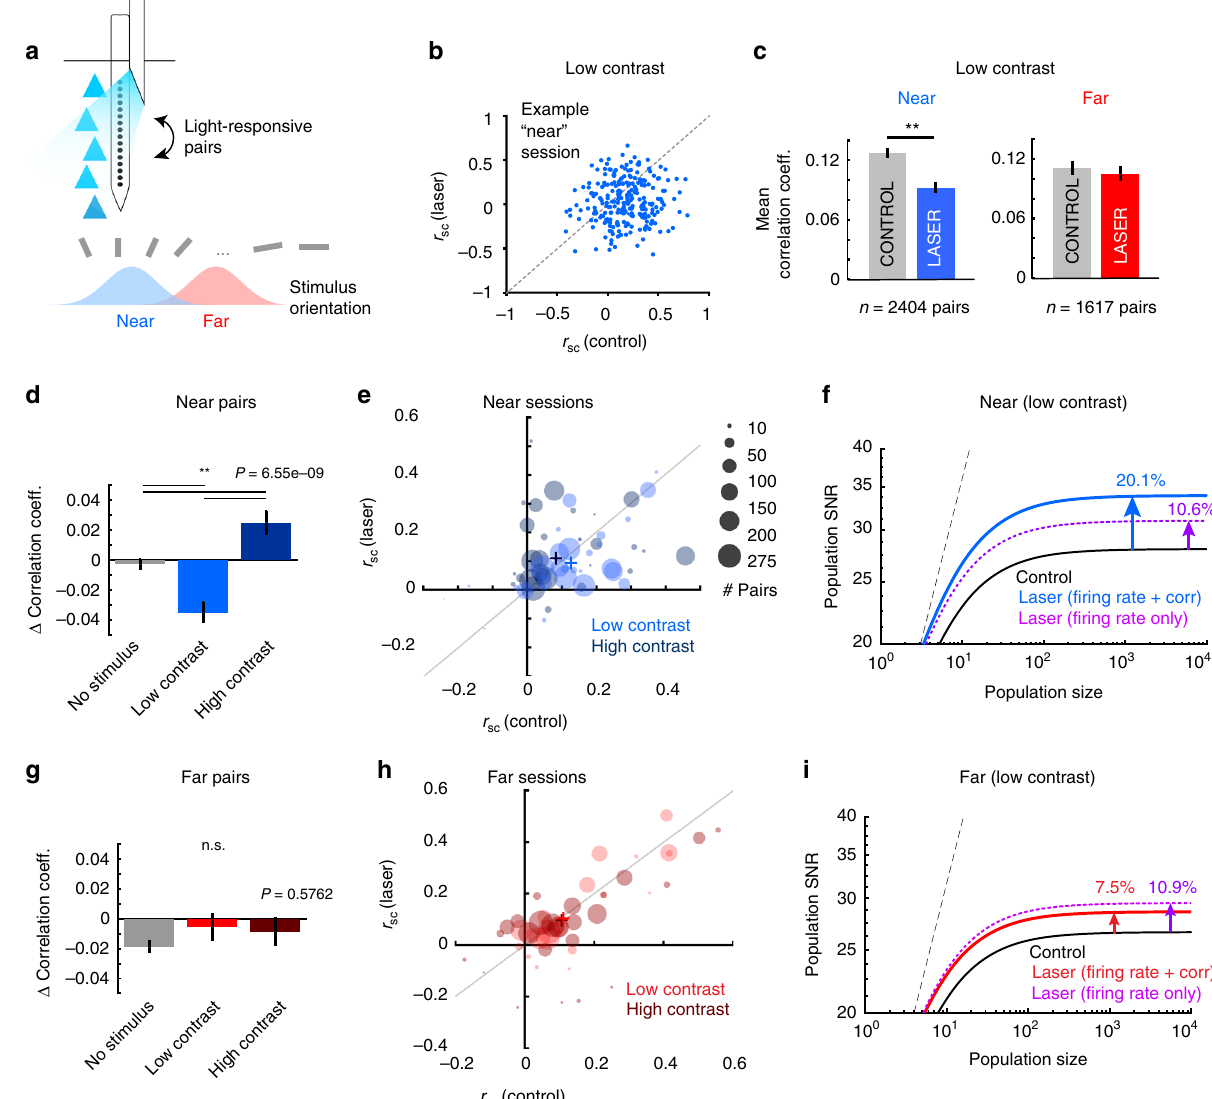
Fig. 4 Optogenetic stimulation alters noise correlations and network performance in the “ near ” condition. a Noise correlations between light-responsive pairs along laminar electrode were measured across stimulus conditions. b Changes in noise correlations ( “ r sc ” ) for one example “ near ” condition session, during low contrast stimulus presentation. Each point represents correlation coef fi cients for one pair of laser-responsive cells in control and laser trials. c Population mean noise correlations for laser-responsive cell pairs during control (gray bars) and laser trials (colored bars) for “ near ” (left panel, blue) and “ far ” (right panel, red) conditions during low contrast presentation. (**Near sessions: P = 2.85e-6, Wilcoxon signed rank test, z-statistic = − 4.68. Far sessions: P = 0.25, Wilcoxon signed rank test, z-statistic = − 1.14). Error bars represent s.e.m. d , g Mean change in noise correlations following optogenetic stimulation for “ near ” ( d ) and “ far ” ( g ) across all stimulus conditions. Kruskal – Wallis test. Error bars are s.e.m. e , h Mean change in noise correlations for individual “ near ” ( e ) and “ far ” ( h ) sessions, at low (light circles) and high (dark circles) contrasts. Plus signs indicate cross session pair mean in each condition. Area of circle is proportional to the number of pairs from each session. f , i Impact of noise correlation changes on population SNR. Plots show SNR for hypothetical populations of increasing size for “ near ” ( f ) and “ far ” ( i ) subpopulations during presentation of low contrast stimuli. Solid lines show the SNR values during the control (black), and laser conditions for “ near ” (blue, f ) and “ far ” (red, i ) activated populations. Dotted magenta lines represent the change in SNR attributable to light-induced increase in fi ring rates alone, if noise correlations remain unchanged. Dashed black line represents the hypothetical SNR if there was no correlated noise